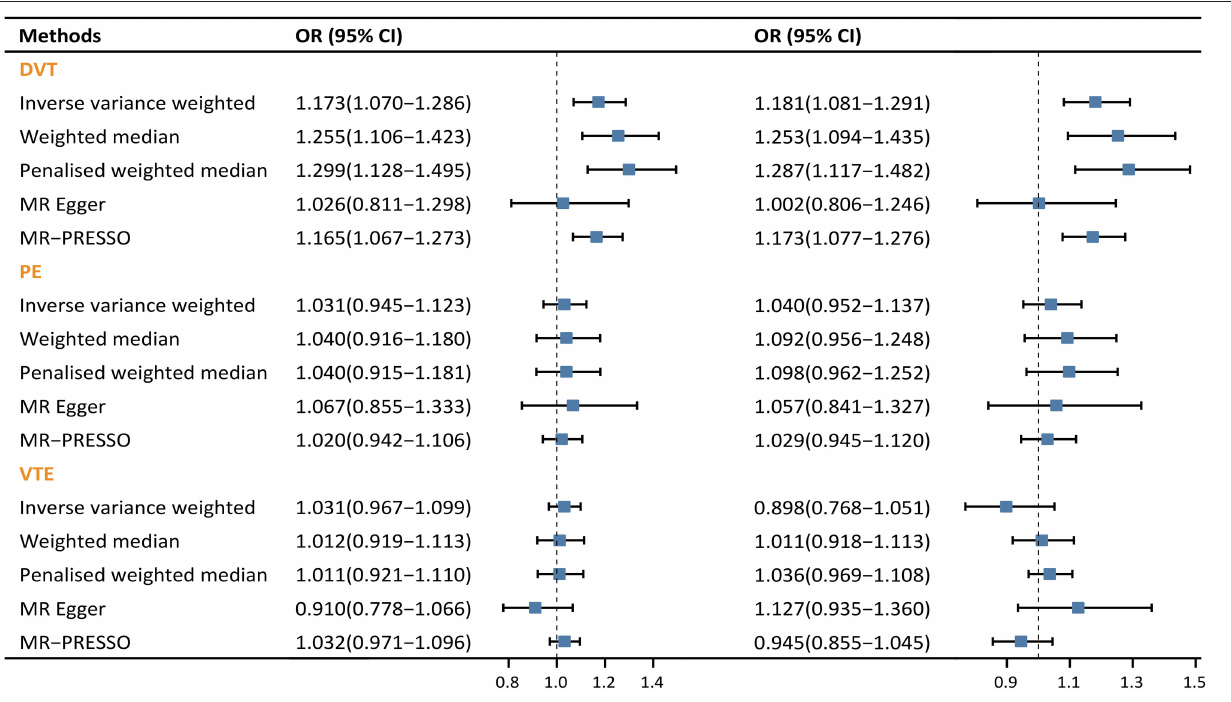
FIGURE 3 | Forest plots of causal effect of varicose vein on venous thromboembolic diseases. (Left) MR analysis using all 21 qualified SNPs. (Right) MR analysis using 19 SNPs that have no genome-wide association with confounders. CI, confidence interval; OR, odds